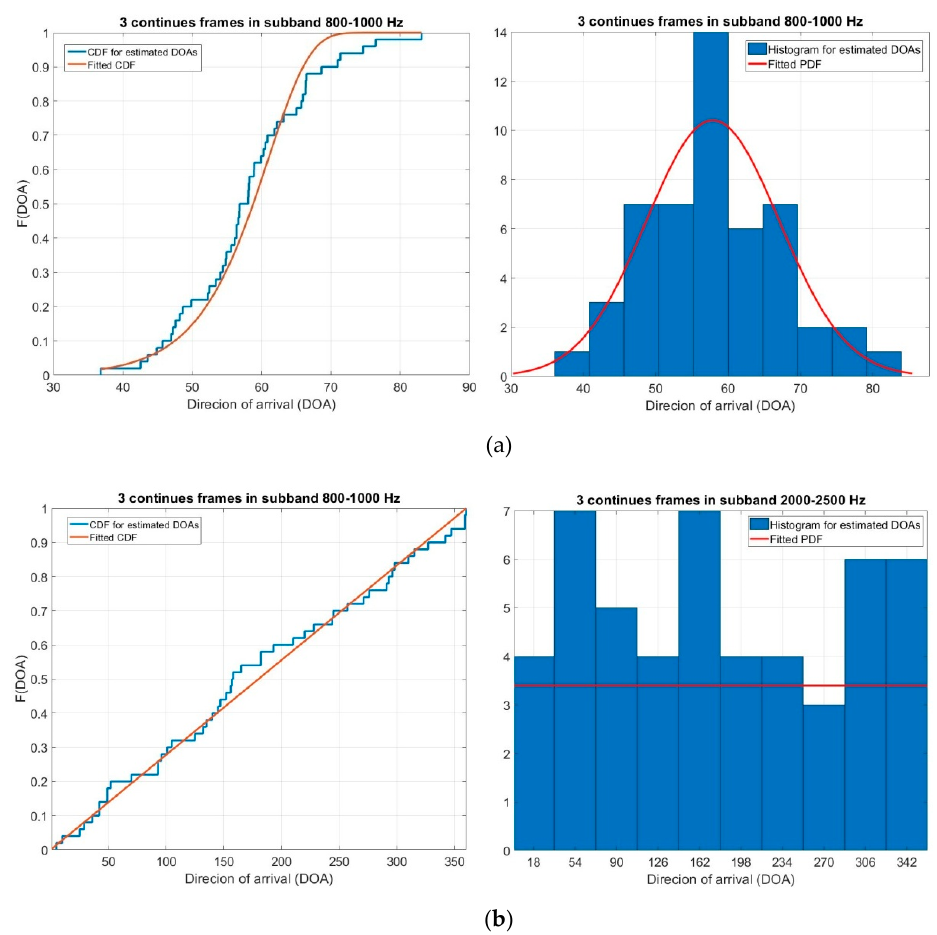
Figure 11. The cumulative distribution function (CDF) and probability density function (PDF) diagrams for estimated direction of arrivals(DOAs) of 3 continues frames in ( a ) subband 0.8–1 kHz, ( b ) subband 2–2.5 kHz .